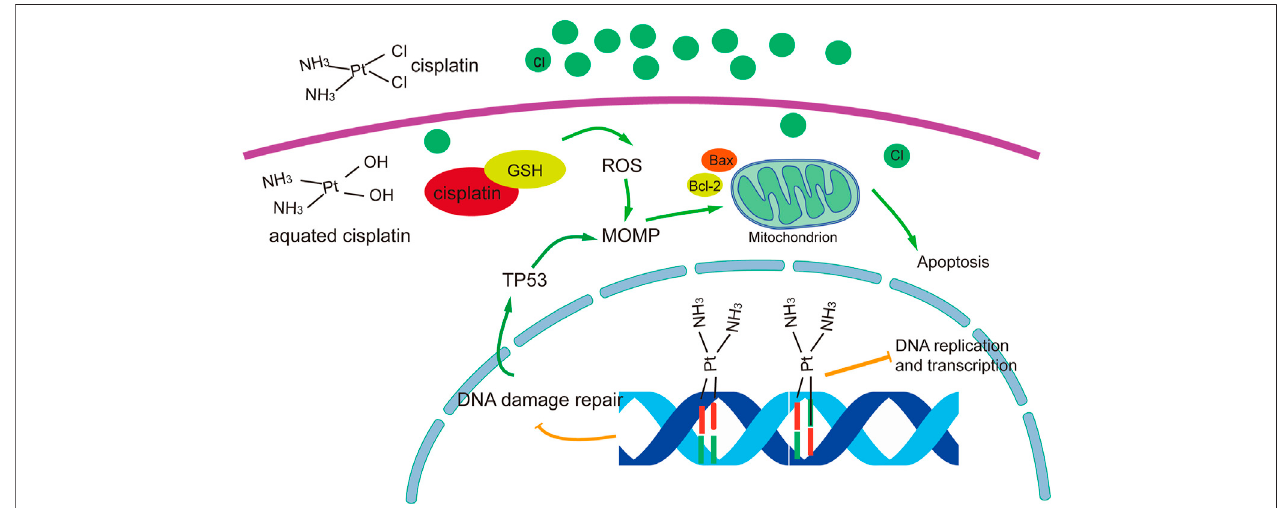
FIGURE 1 | Overview of molecular mechanisms of cisplatin in cancer treatment. The fi gure was drawn in adobe illustrator.